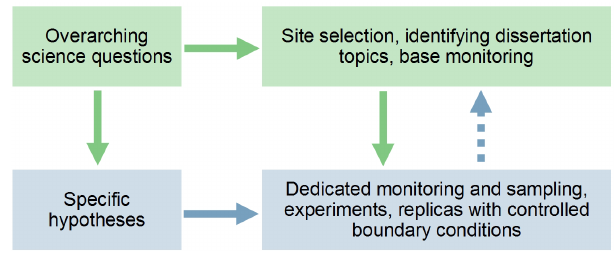
Figure 1. Interplay of hypotheses and experimental planning in the